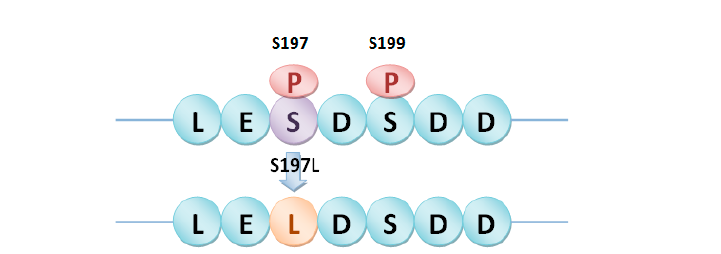
Figure 2. Type I ( − ) and Type II ( − ) phosSNP S197L in LOC_Os05g11370, which removed the experimentally identified protein phosphorylation sites S197 and S199. Blue circle: Amino acid; Purple circle: Amino acid before mutation; Orange circle: Amino acid after mutation caused by phosSNP; Red oval with “P”: Phosphate group; The same as below.